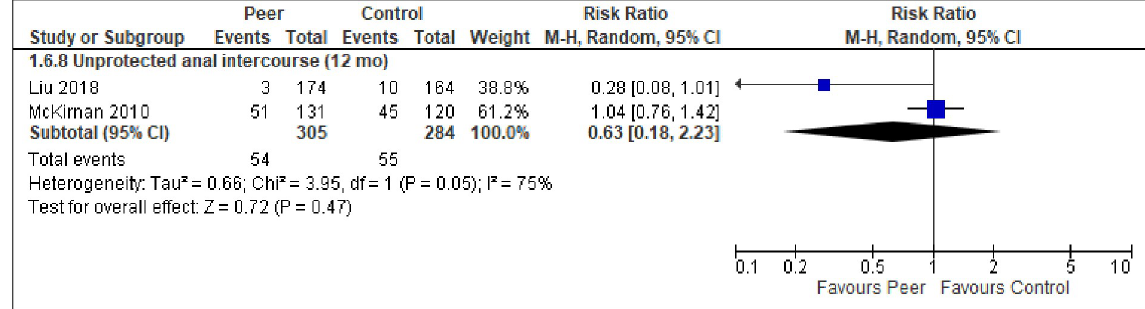
Fig 9. Meta-analysis of outcome unprotected anal